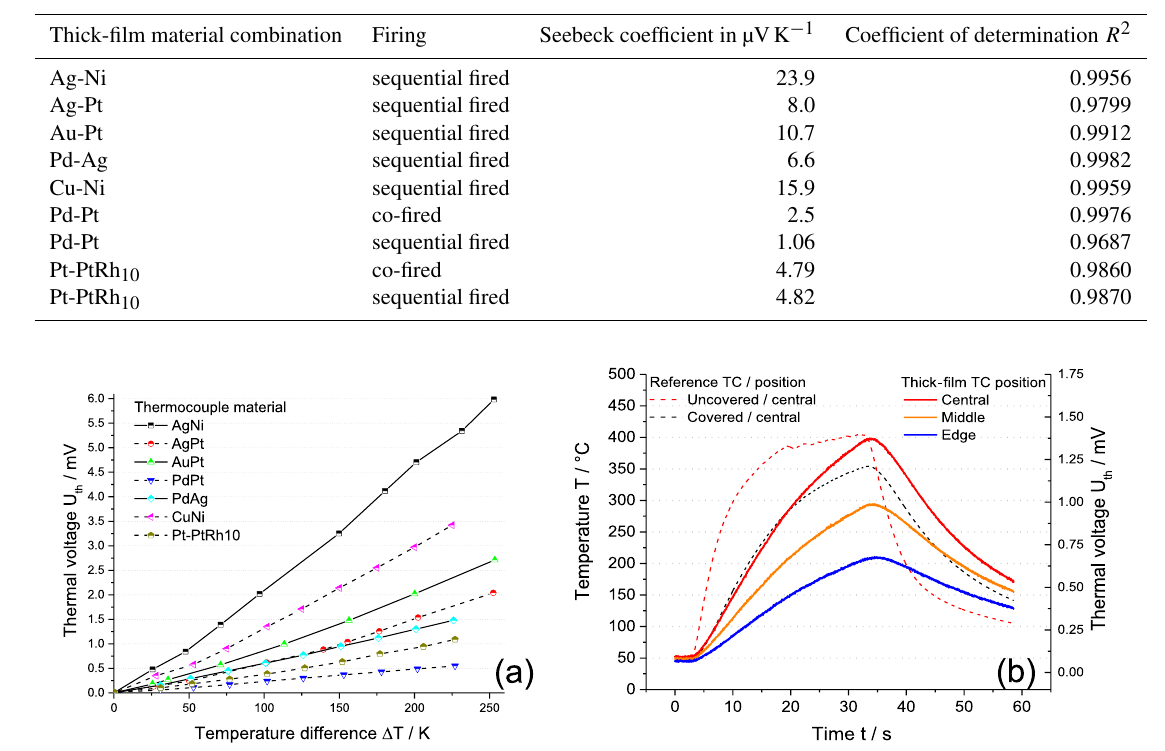
Figure 5. (a) Voltage in dependence of temperature difference and (b) comparison of standard thermocouples and thick-film thermocou- ples under real-world conditions. Pure wire thermocouples (uncovered) and housed thermocouples (covered) were used as reference ther- mocouples (positioned like central thermocouple). Thick-film thermocouples “TC” were positioned 20mm (central), 10mm (middle) and 5mm (edge) from the pipe of the test